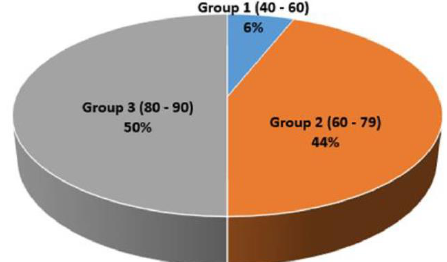
inclination angles and below 80º from the ground surface. Only inclination process of the trees might be controlled by effective landslide mitigation measures in downslope areas.